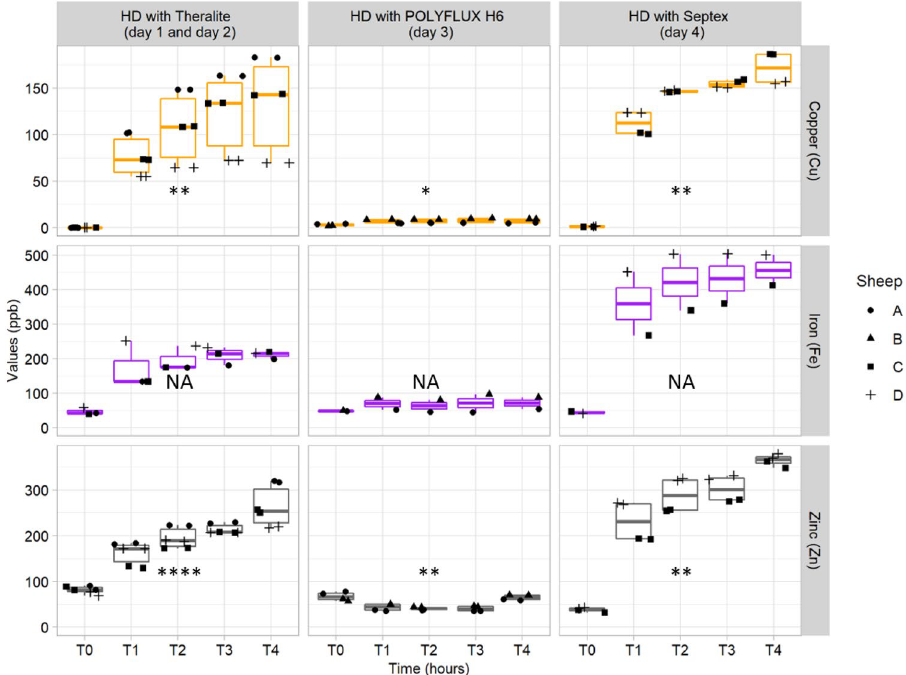
Figure 6. Copper, iron, and zinc (ppb) monitoring by ICP/MS in the dialysis bags along 4 h dialysis sessions on healthy sheep using Theralite membrane (HCO, day 1 and 2, sheep A, C, D), POLYFLUX H6 membrane (HF, day 3, sheep A and B) or SepteX membrane (HCO, day 4, sheep C and D). All sheep (n = 4) experienced two dialysis treatments with one treatment failure, resulting in 7 dialysis sessions only. For copper and zinc, two isotopes were analyzed (Cu 63 and Cu 65; Zn 66 and Zn 68) while iron was only represented by the Fe 56 isotope. Stars indicates significant change in abundance with time according to non-parametric